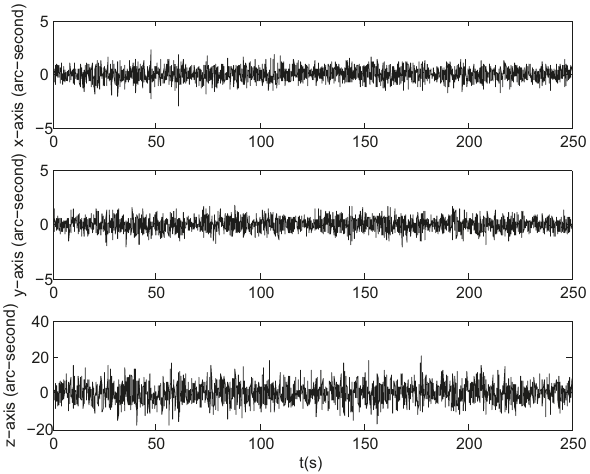
Figure 8. Attitude estimation errors in simulation.